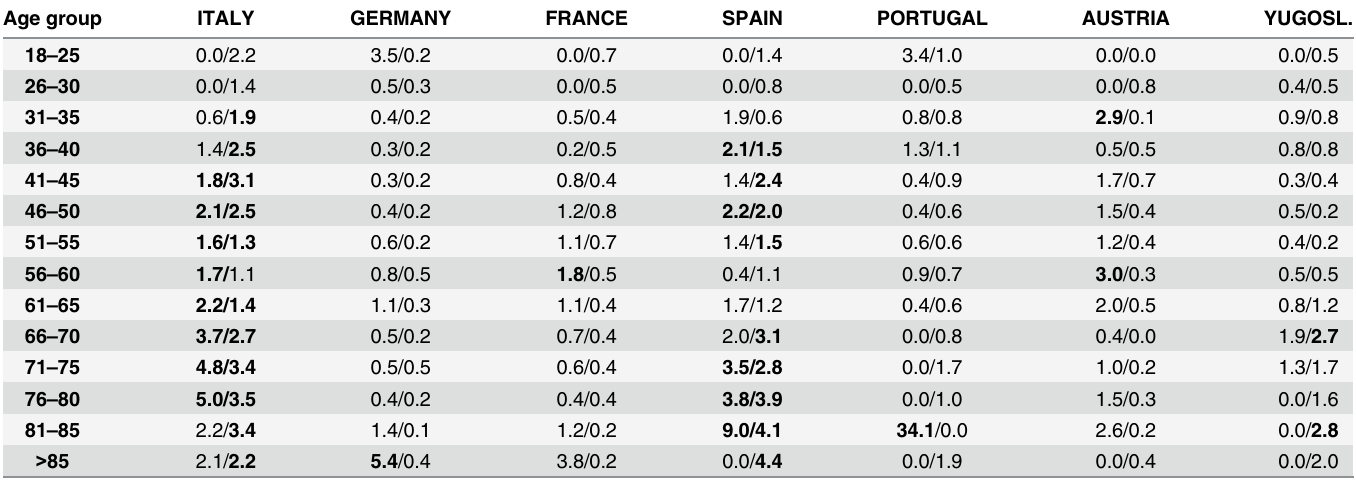
Table 2. Ratio of proportions in the Swiss Hepatitis C Cohort Study (SCCS) respectively in cases mandatorily reported to the Federal Office of Pub- lic Health (FOPH) compared to the proportion in the general population, by country of birth/origin and age